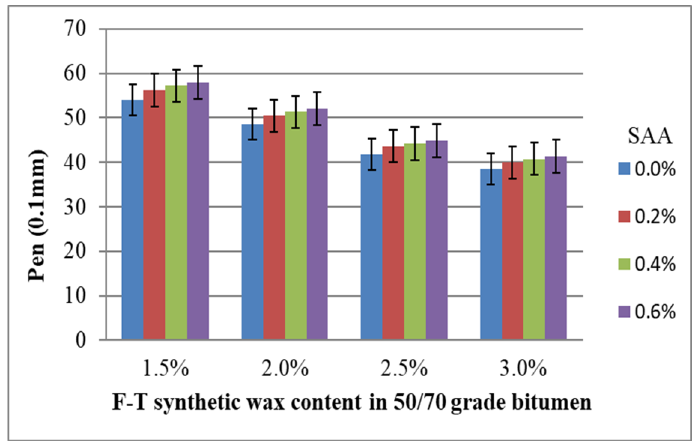
Figure 4. Penetration value of modified bitumen 50/70 versus F–T wax and SAA contents.